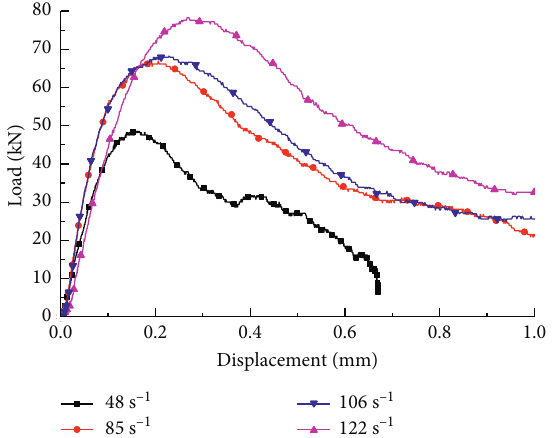
Figure 4: Dynamic splitting tensile load-displacement curves of the limestone disk specimen ( P s � 0MPa).